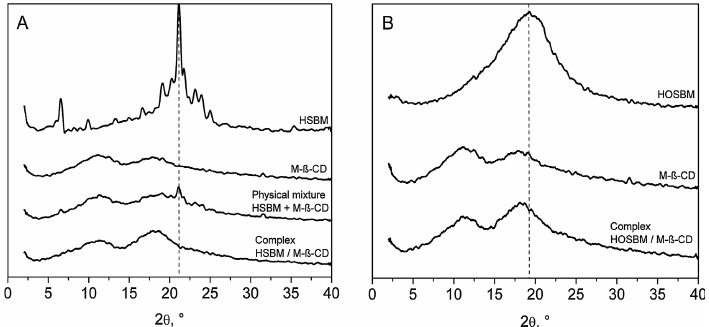
Figure 16. PXRD spectra of POBMs, methyl- β -cyclodextrin, their physical mixture, and inclusion complexes ( A ) – H-SBM, ( B ) – HO-SBM. Reprinted from [32]. Copyright (2018), with permission from Elsevier.